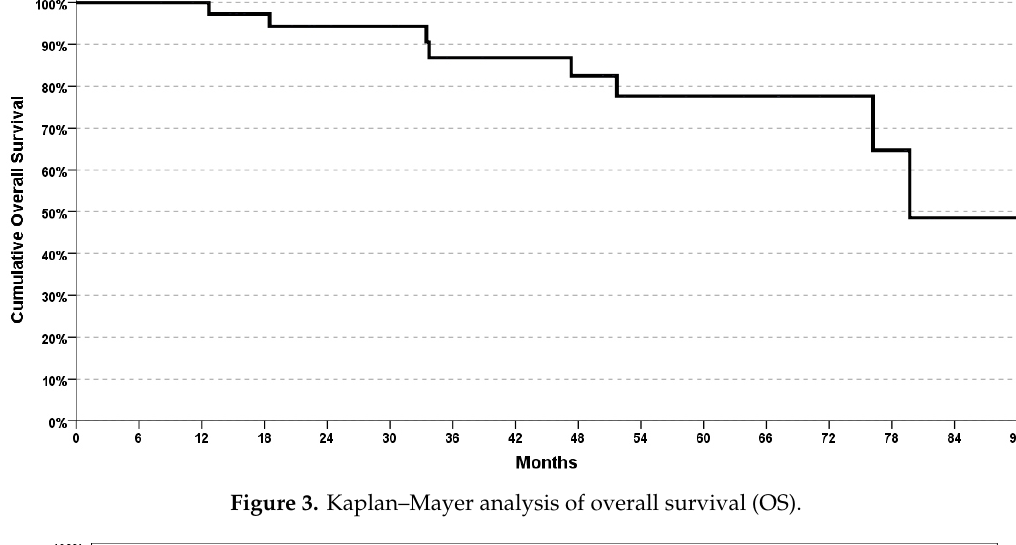
Figure 3. Kaplan–Mayer analysis of overall survival (OS).